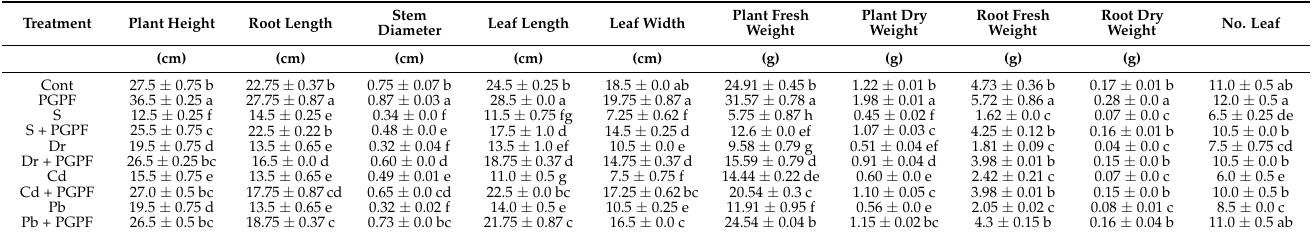
Table 1. Effects of PGPF inoculation on tomato plant growth parameters under normal and stress conditions after 10 days of treatment.